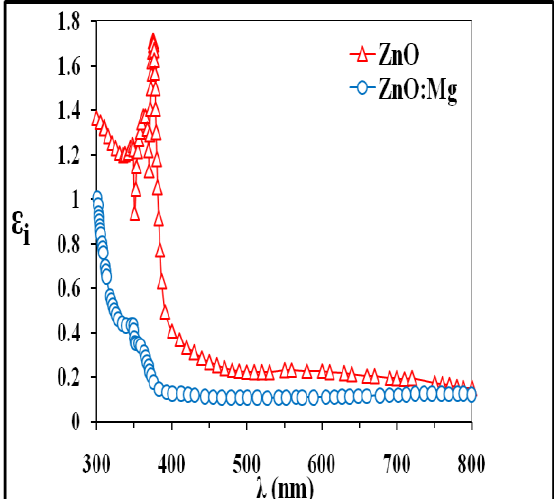
Fig.7:Variation of ε pure and doped films.